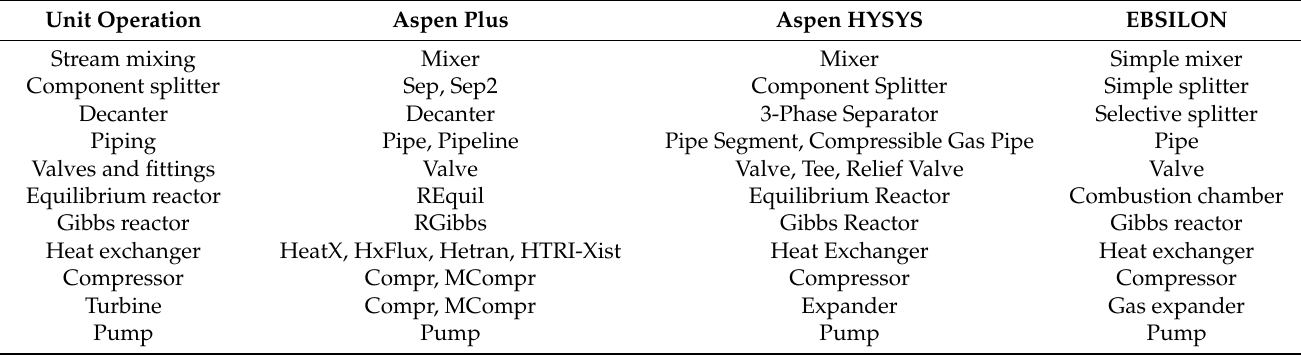
Table 1. Comparison of units in Aspen Plus, Aspen HYSYS, and